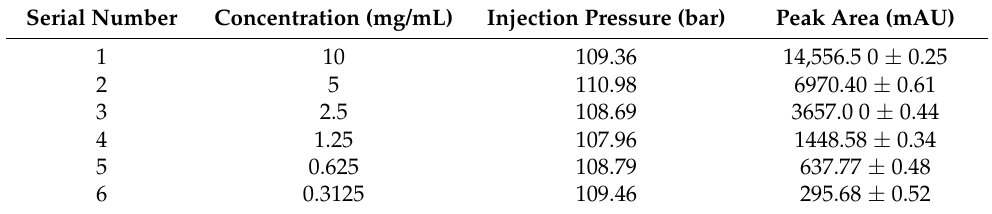
Table 1. Liquid chromatography standard curve and corresponding peak